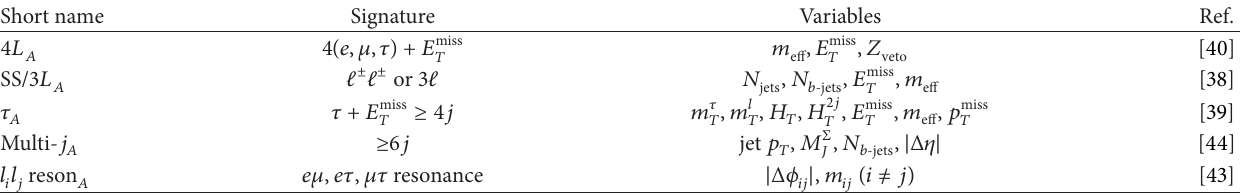
Table 1: Overview of ATLAS analyses designed to probe prompt RPV models. The signature descriptions are indicative only, and further details can be found in the analysis documentation in each case.